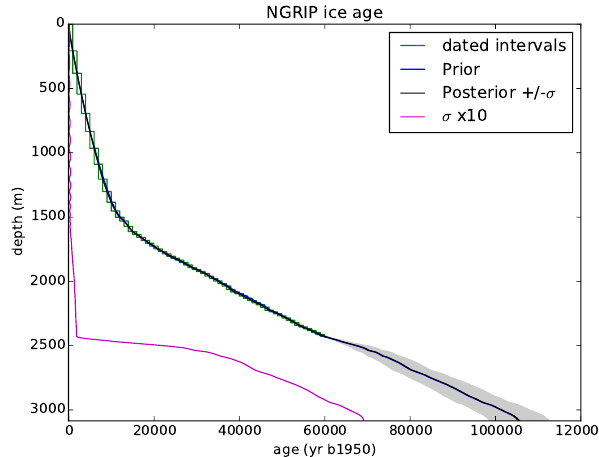
Figure 6. Experiment test-ice-intervals-with-known-durations. NGRIP prior (blue) and posterior (black) chronologies and the posterior confidence interval (grey area) when using independent 1kyr long intervals with known durations from the GICC05 layer- counted timescale (green rectangles; Svensson et al., 2008). The 1 σ uncertainty of the posterior timescale is also shown on the left (pink). This figure is automatically produced by